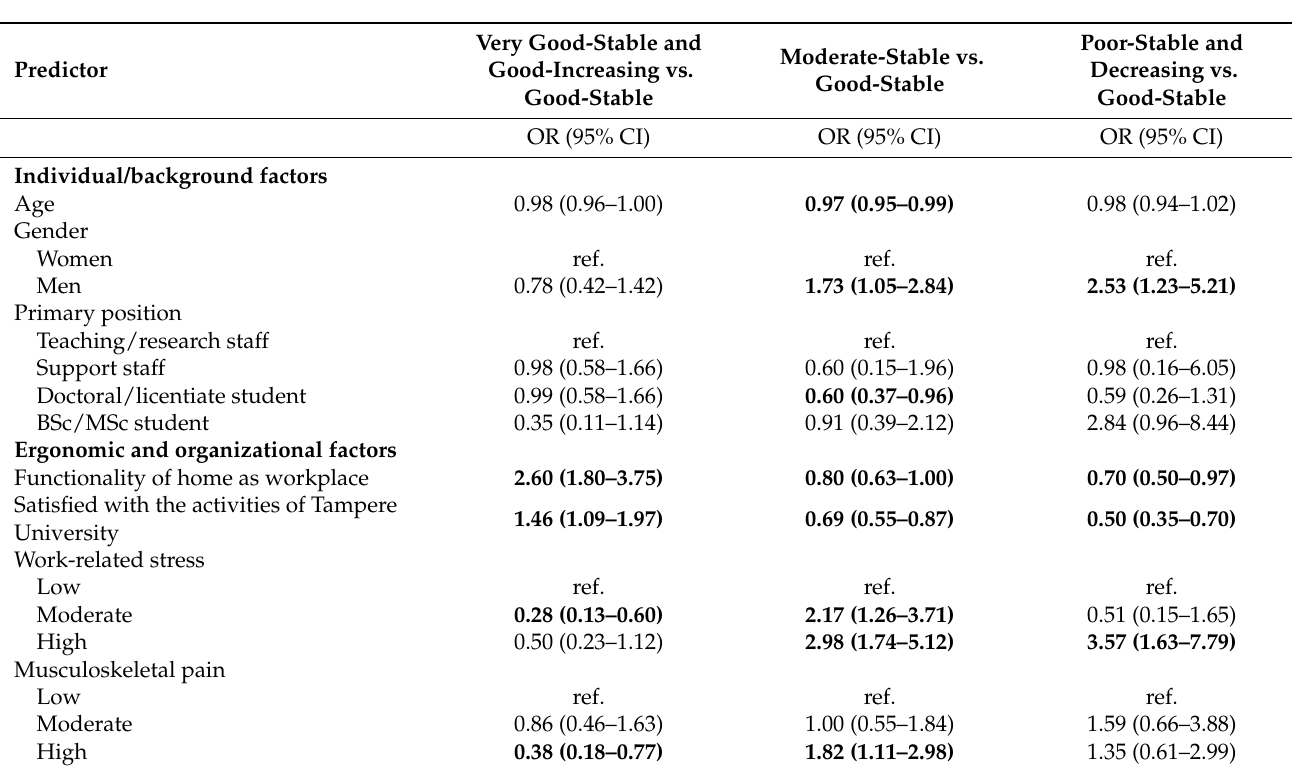
Table 3. Multivariate associations between profiles of work ability among university staff during COVID-19 lockdown with baseline predictors. Multinomial logistic regression analysis OR and 95% confidence intervals